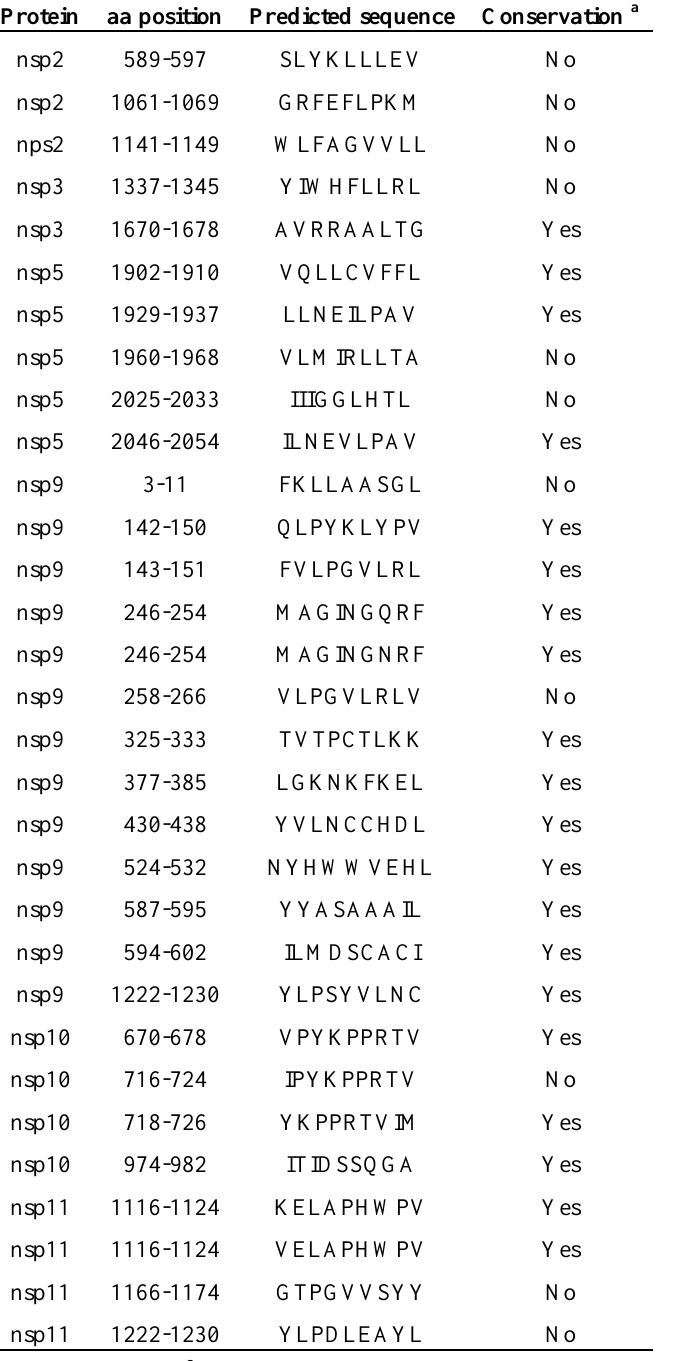
Table 1. Peptides predicted as T-cell epitopes of non-structural proteins (nsp) of porcine reproductive and respiratory syndrome virus (PRRSV) analyzed in the present